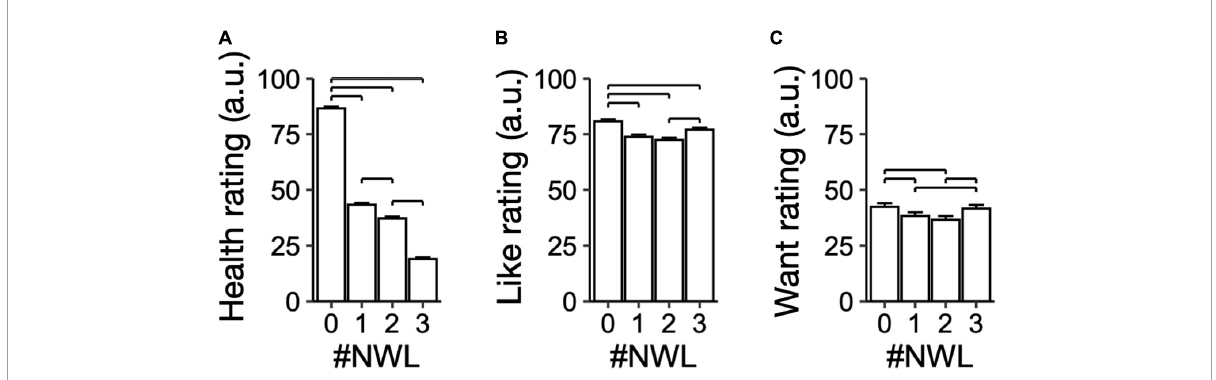
FIGURE2 Subjective health, like, and want ratings made without showing nutrient warning labels (NWL). Visual analog scales (VAS) ratings for subjective (A) Health, (B) Like, and (C) Want for all foods used in the study made in the absence of NWL. Foods were grouped based on the actual number of NWL of foods. Brackets, P < 0.05 for pairwise comparisons.